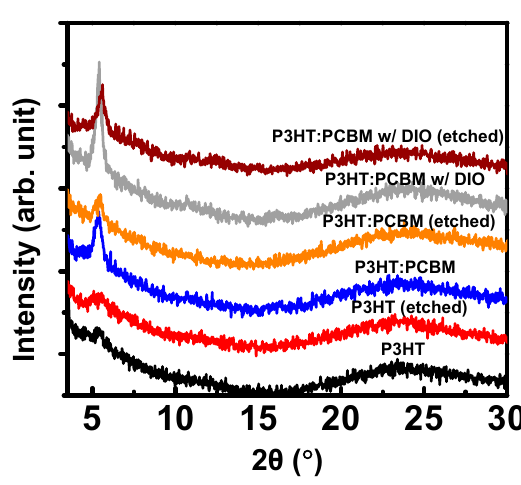
Figure 3. X-ray di ff ractometer (XRD) of thin films of the P3HT and P3HT:PCBM blends under various Figure 3. X-ray diffractometer ( XRD) of thin films of the P3HT and P3HT:PCBM blends under various conditions.